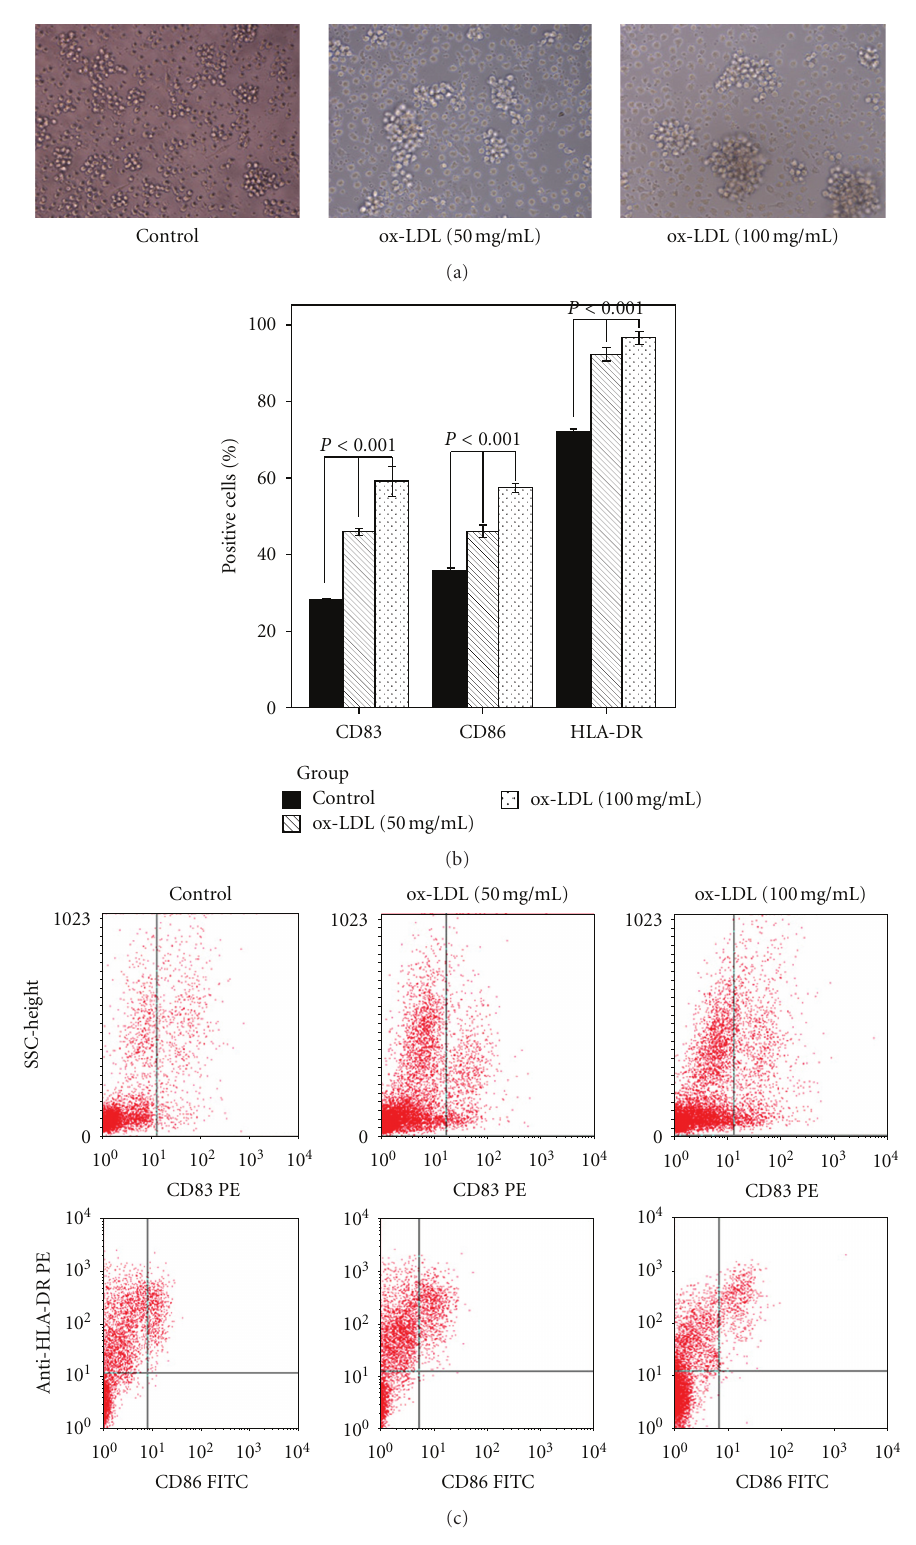
Figure 2: ox-LDL-induced morphological and phenotypic change in monocyte-derived DCs. Immature DCs were treated with di ff erent concentrations of ox-LDL in DC medium supplemented with 50ng/mL GM-CSF (Peprotech) and 50 ng/mL IL-4 for 24h. (a) DCs morphology were visualized by conventional light microscopy. (b) and (c) Cell surface molecules (CD83, CD86, and HLA-DR) were examined by FACS analysis. P < 0 . 001 compared among di ff erent concentration of ox-LDL-stimulated